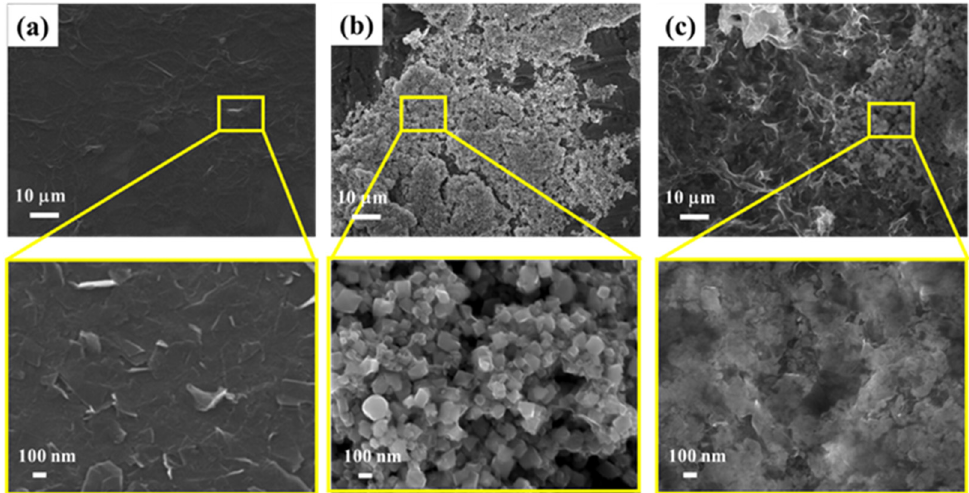
Figure 1. SEM images of ( a ) rGO, ( b ) 5 wt% Mn@rGO, and ( c ) 5 wt% Ni@rGO. Yellow boxes indicate areas corresponding to magnified images below.